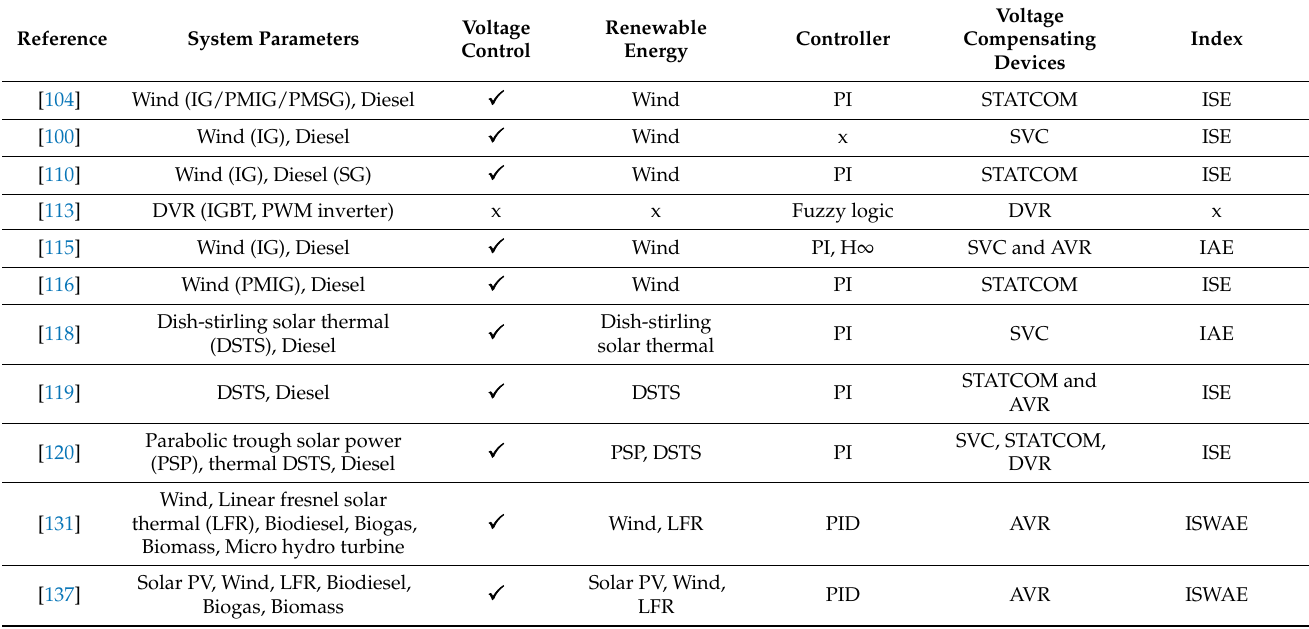
Where tick mark (  ) represents presence of feature and cross mark (x) represents absence of feature in the system.